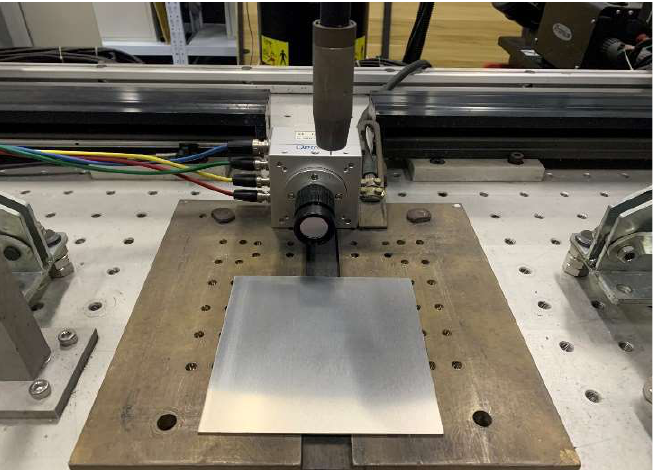
Figure 1. CMT molten pool flow experiment device.